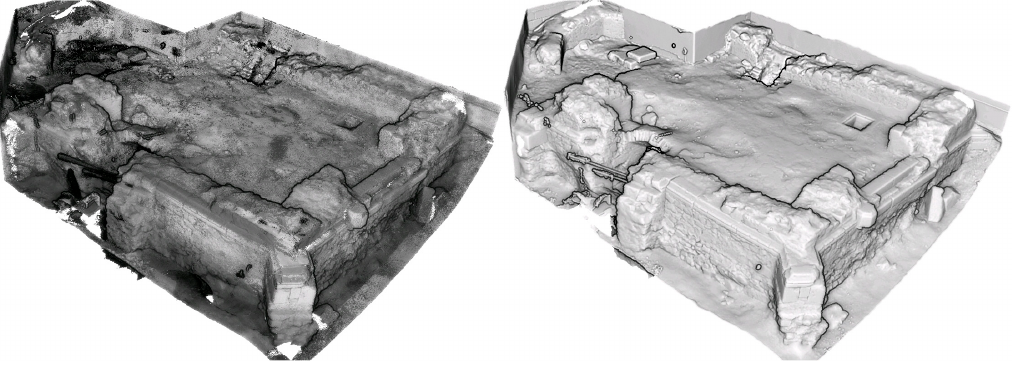
Figure 8. Point cloud from TLS colored using the reflection intensity ( left ), and the resulting mesh from Metashape ( right ).